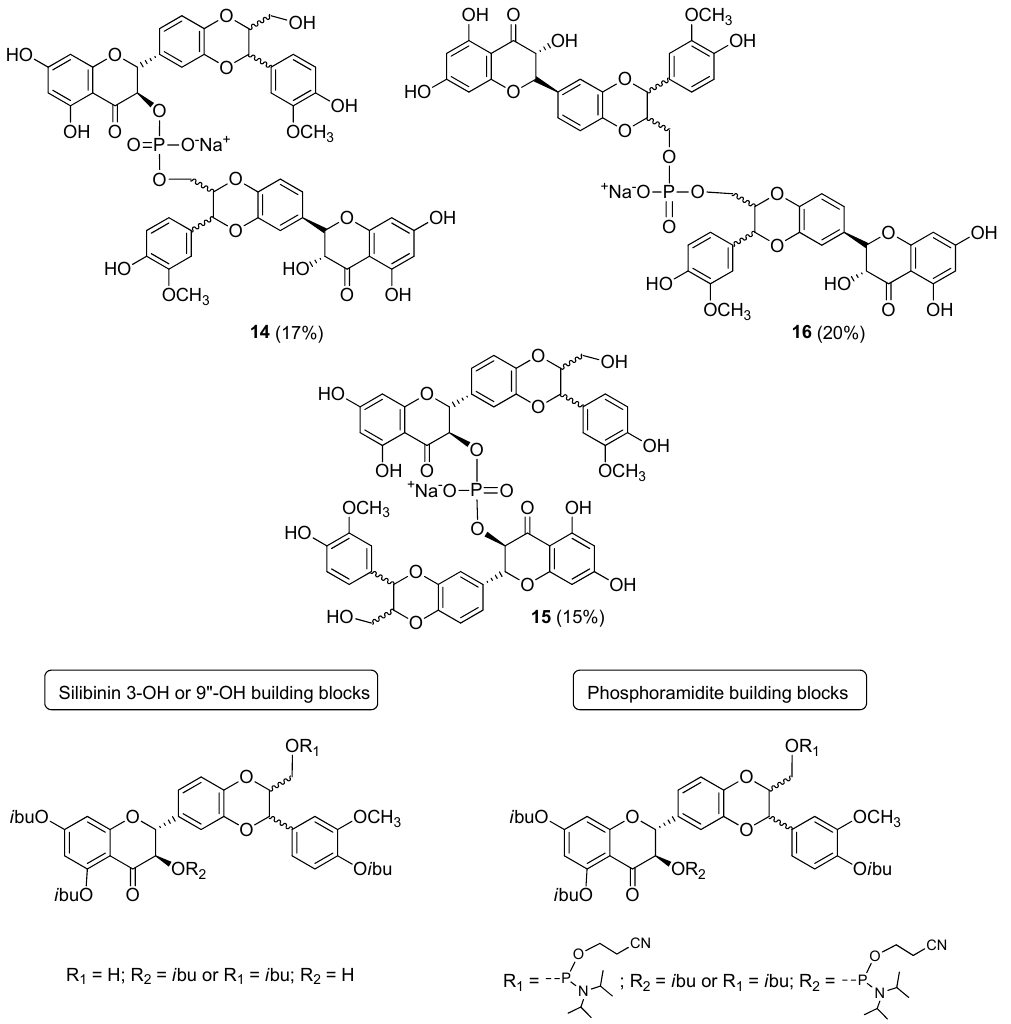
Figure 7. Phosphate-Linked Silibinin dimers (PLSd) and building blocks useful for their synthesis.